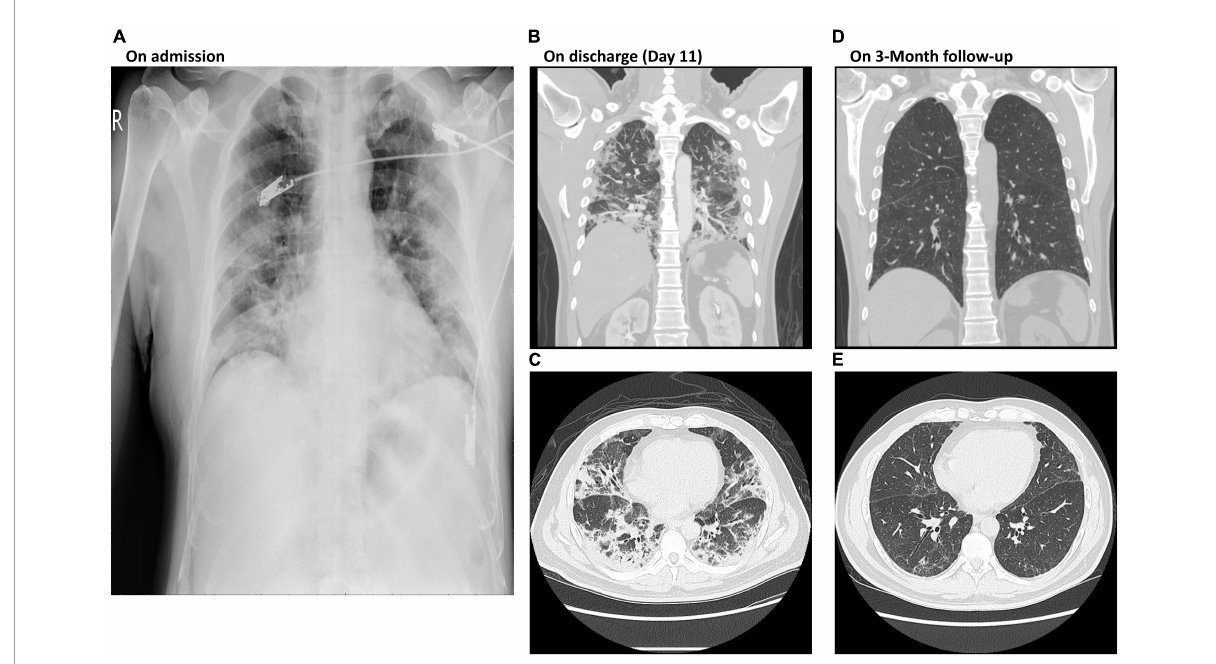
FIGURE1 Chest X-rays of Case II on admission and at 3-month follow-up post discharge. (A) Diffuse bilateral lung infiltration shown by chest X-ray on admission. (B,C) Patchy shadows of high density in lobule were detected by CT images on discharge at day 11. (D,E) Clear CT images show both lobules without patchy shadows at 3-month follow up post discharge. CT, computer tomography; PCR, polymerase chain